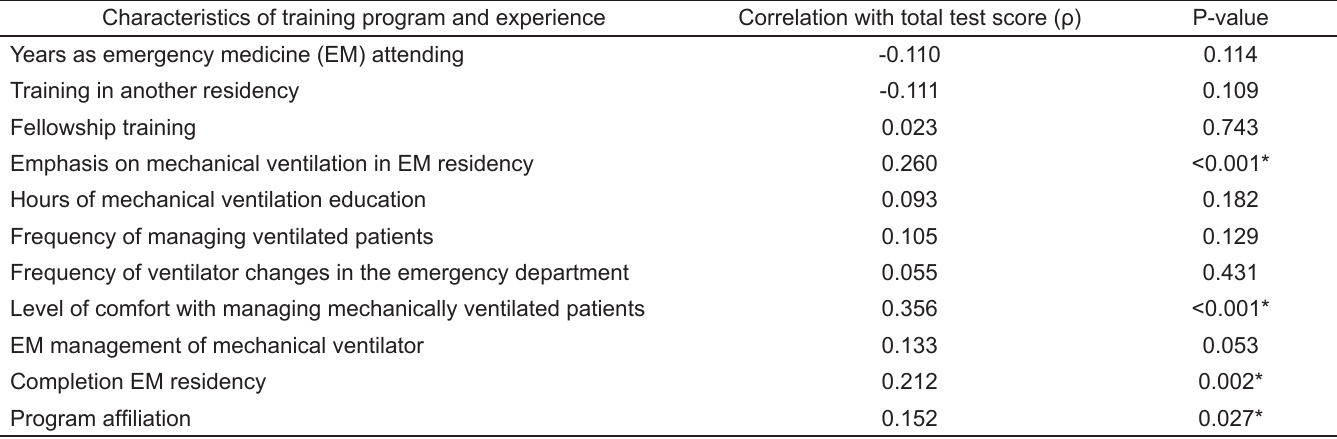
*Statistically significant correlation